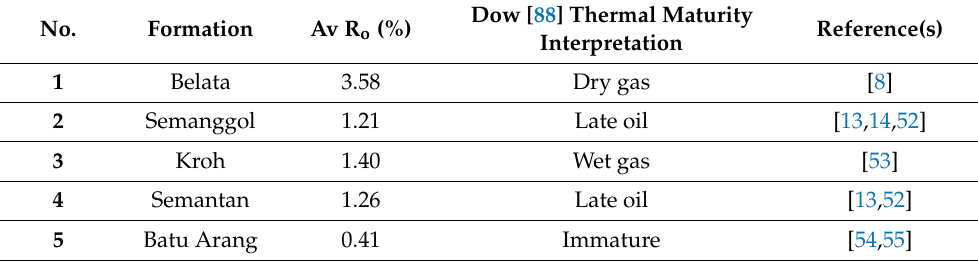
Table 6. Thermal maturity interpretation for formations in PM according to Dow [88] using R o .